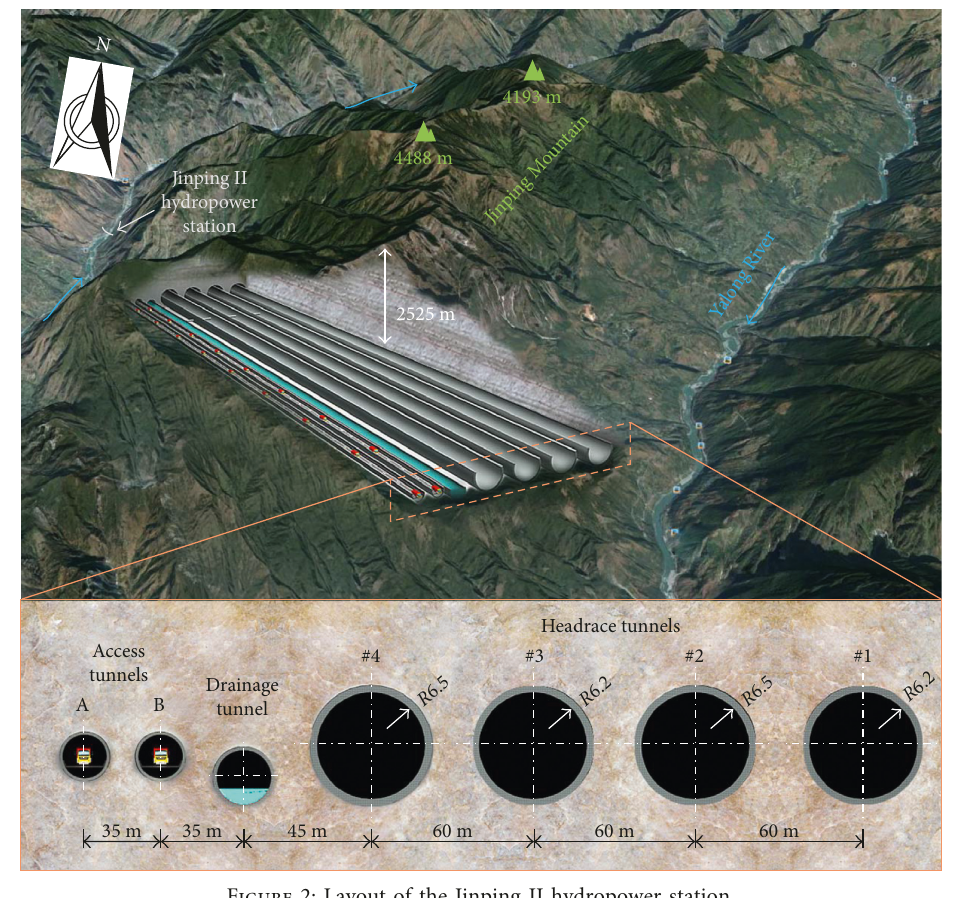
Figure 2: Layout of the Jinping II hydropower station.